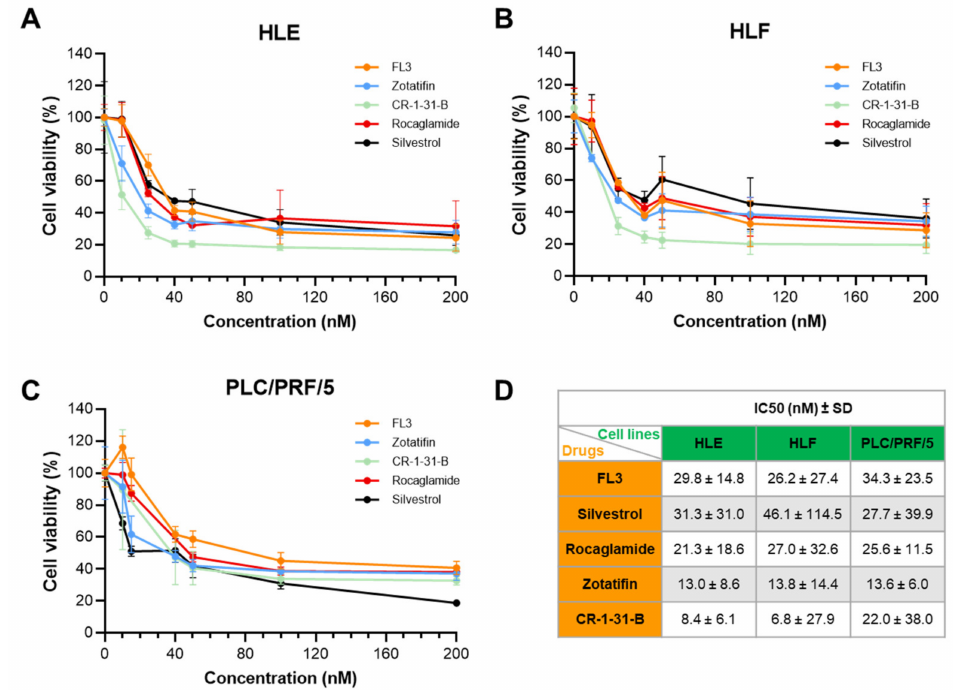
Figure 6. Cell viability of human hepatocellular carcinoma cell lines exposed to eIF4A inhibitors, as assessed by MTT assay. The eIF4A1 inhibitors, FL3, Zotatifin, CR-1-31-B, Rocaglamide, and Silvestrol, were administered to HLE ( A ), HLF ( B ), and PLC/PRF/5 ( C ) cell lines. Similar data were obtained in the SNU449 cell line (not shown). Data of two independent experiments with n = 4 technical replicates are represented as the percentage of DMSO-treated cells ± SD. A summary of the IC50 ± SD of the five drugs in the three cell lines is depicted in ( D